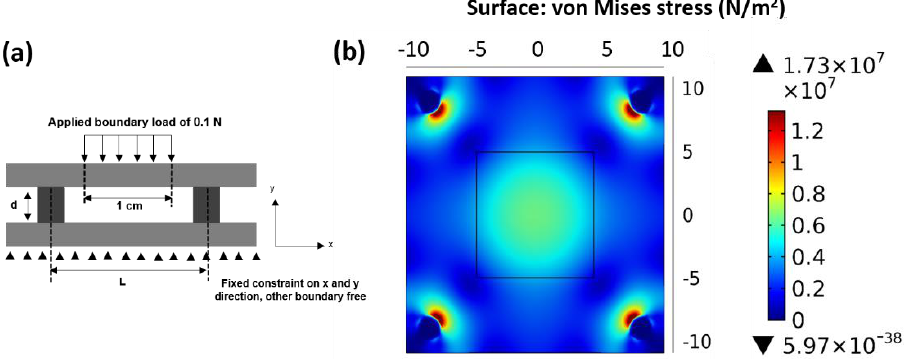
Figure 9. ( a ) Unit structure and boundary conditions for the finite element analysis (FEA) on the micropillar-based structure; ( b ) A typical FEA results from stress distribution for the calculation of apparent elastic modulus of the micropillar-based structure, L = 18 mm.